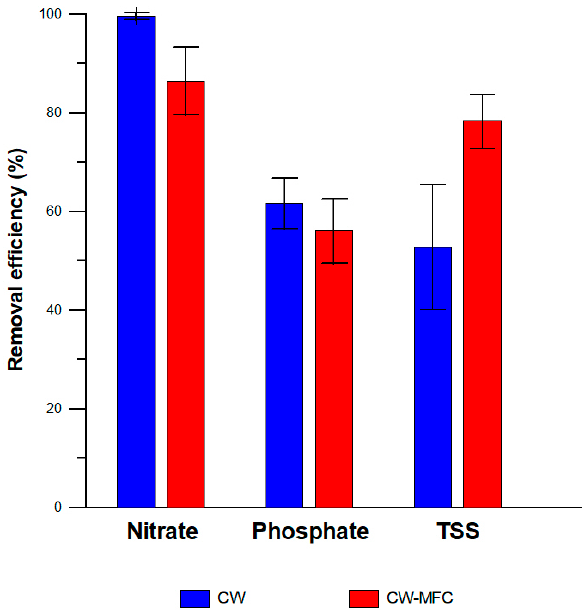
Figure 3. Mean nitrate and phosphate removal efficiency corresponding to the last three batch cycles, and total suspended solids (TSS) removal efficiency corresponding to the last batch cycle in constructed wetlands (CW) (blue) and CW-MFC (red) reactors. Error bars indicate the standard deviation calculated from four measurements for nitrate and phosphate, and from two measurements for TSS.